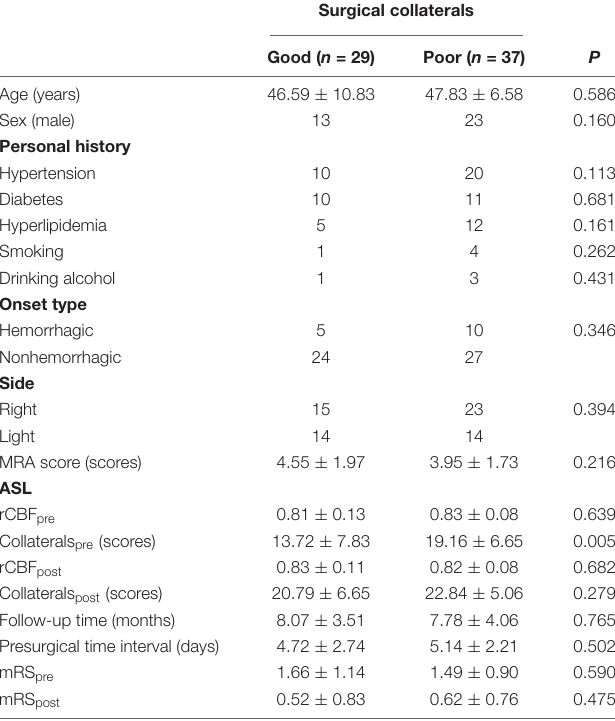
TABLE 1 | Demographic and radiological information of included